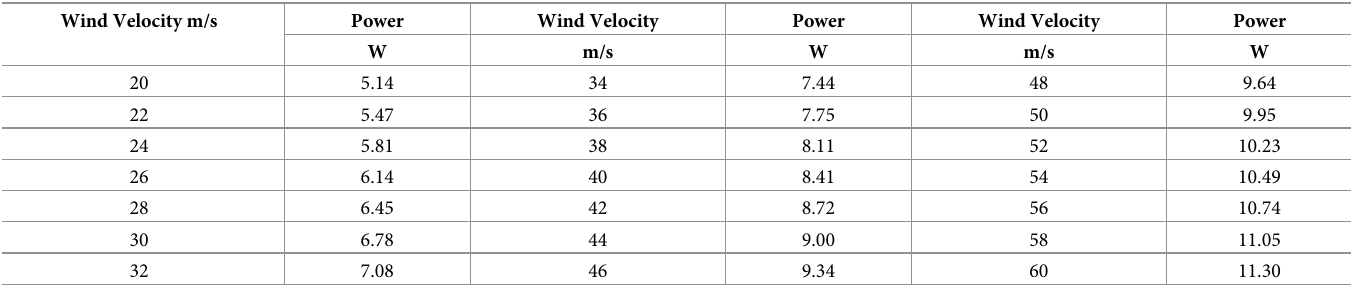
Table 2. Wind velocity and coil heating power in CTD